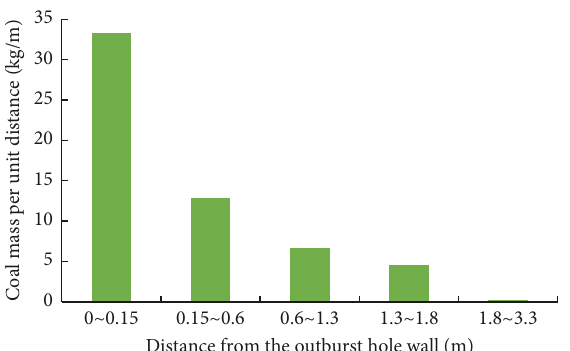
Figure 9: The mass distribution of outburst pulverized coal per unit distance.